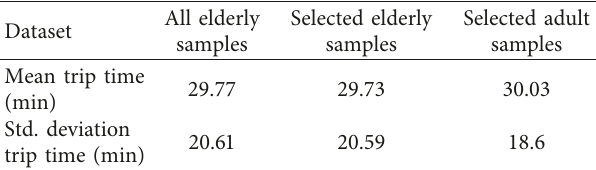
Table 3: The features of trip time across different